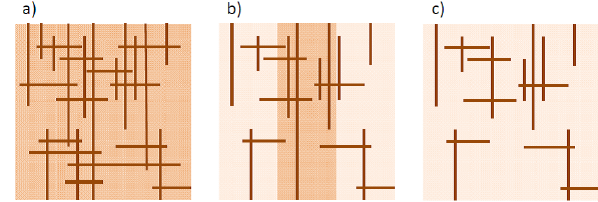
Figure 9. Schematic illustration of the relationship between local connectivity of the pore network, macroscopic (Darcy scale) hy- draulic conductivity and preferential transport (a) this represents a well-connected macropore network (a single pore cluster) with a uniformly high macroscopic hydraulic conductivity denoted by dark shading. The degree of preferential transport is consequently low (b) this network was created from the a-network by removing some pores to create seven isolated pore clusters. It represents a macropore network which is poorly connected locally, but which exhibits a high degree of preferential transport because one of the pore clusters is still continuous through the sample. At the Darcy scale, this is reflected in a continuous high conductivity pathway through the sample (dark shading) surrounded by low conductivity matrix (light shading) (c) this shows that removing one more pore results in a breakdown of sample-scale continuity, which will limit preferential transport. Macroscopic hydraulic conductivity is now uniformly